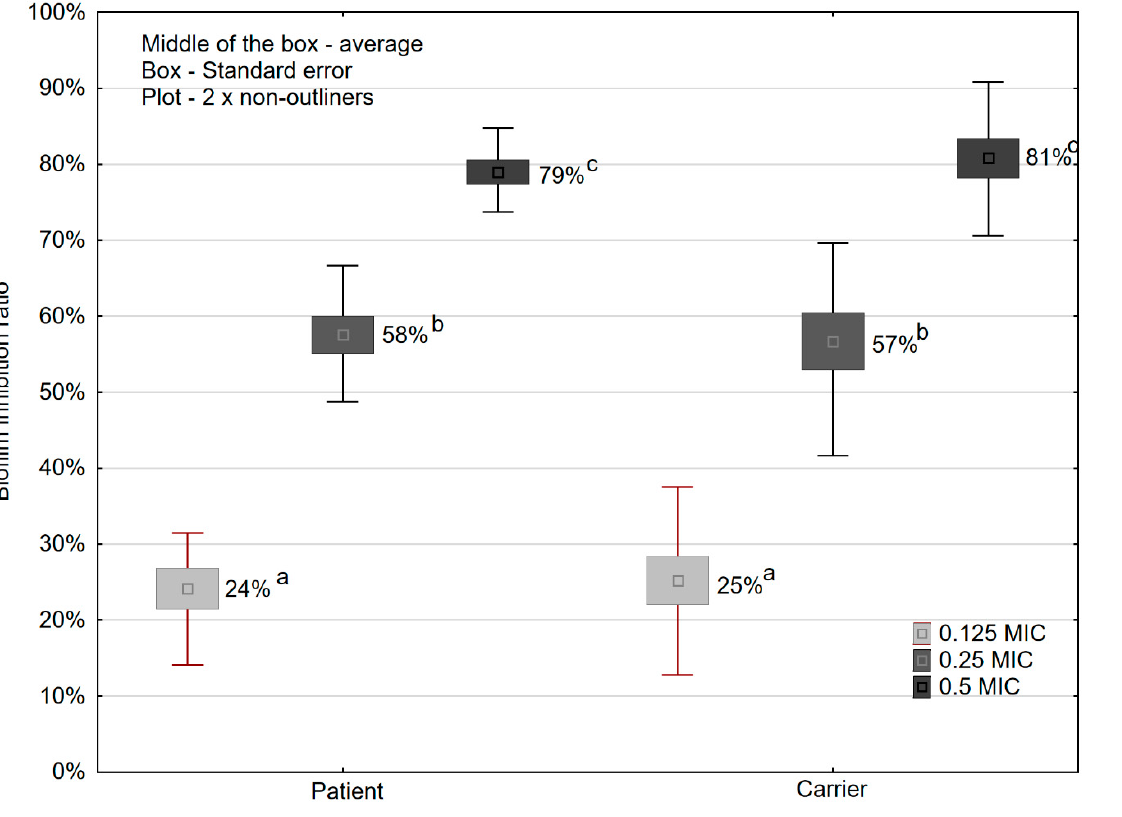
Figure 4. S. enterica ( n = 69) biofilm inhibition ratio in the presence of ampicillin sub-MICs. (a, b, c, values marked with different letters differ statistically significantly ( p ≤ 0.05) .